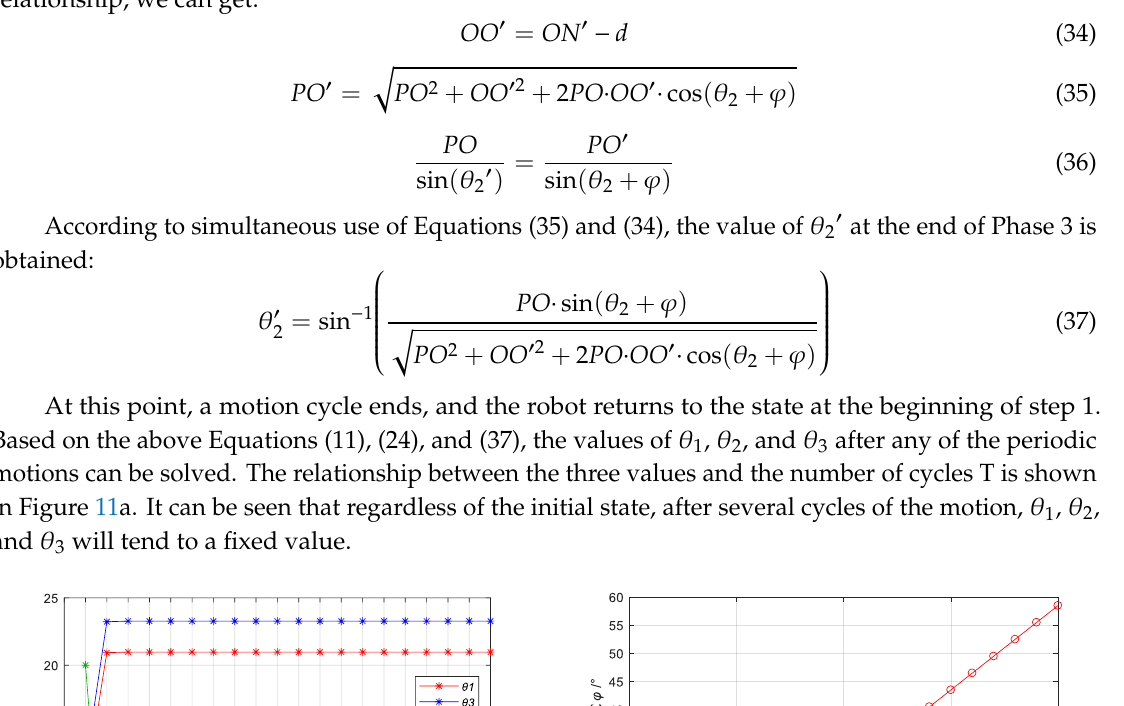
( b ) Figure 12. ( a ) Simulation diagram of the motion trajectory of the robot. The blue dotted line in the figure indicates the trajectory of the robot's center point in 120 cycles (at the initial phase: 𝐿 2 = 400 𝑚𝑚 ). The red line in the figure indicates the specific position and posture of the robot when T = 0, T = 30, T = 60, and T = 90. The red dot in the figure is the three bearing hinge points of the robot. It can be seen that during the steering process, the motion trajectory of the robot is circular, and the radius is related to the initial state. ( b ) In a particular case, the robot can avoid an obstacle through adjusting the values of 𝐿 1 and 𝐿 2 at each of the following points: 1) A: 𝐿 1 = 534 𝑚𝑚 , 𝐿 2 = 390 𝑚𝑚 ;